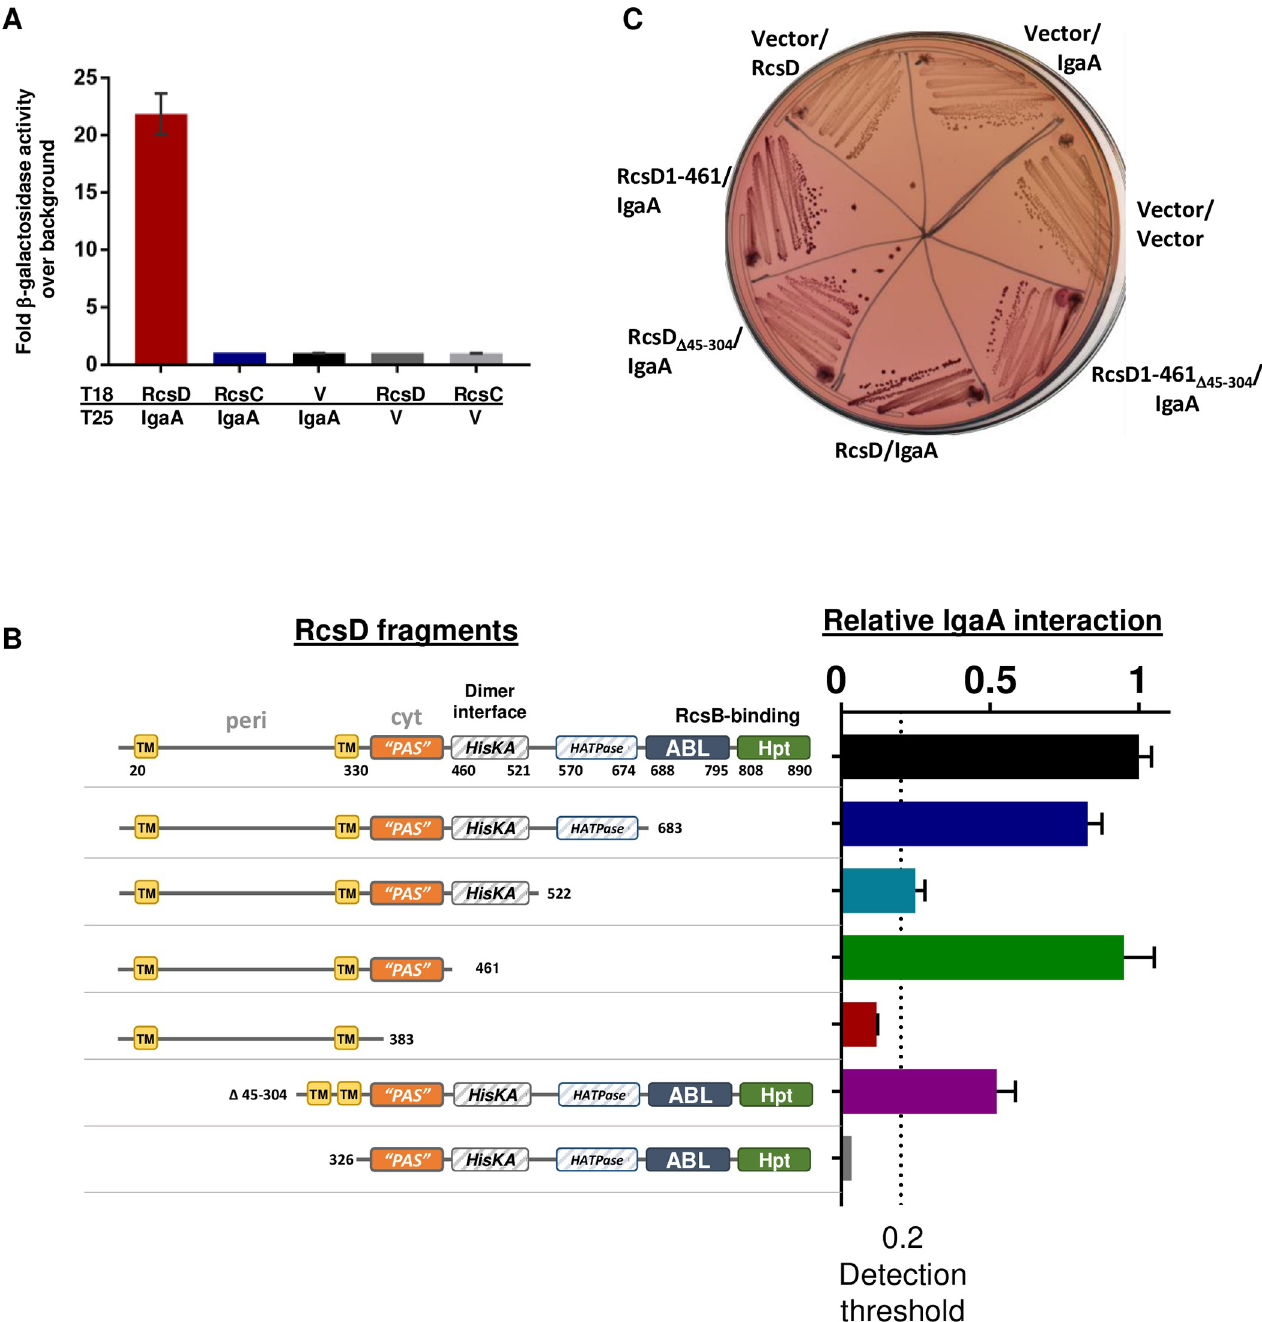
Fig 2. Interaction of IgaA with RcsD. A. Beta-galactosidase activity was measured in cyaA deficient cells (strain BTH101) containing a dual plasmid system encoding the T18 and T25 domains of adenylate cyclase fused to proteins of interest and the expression measured compared to background. Each protein fusion plasmid paired with its cognate vector (V) produces very little activity; the three controls were averaged and used as “background” for normalization. Error bars (some too small to be visible) represent standard deviation of three assays. Fusions present are IgaA-T25, RcsD-T18, and RcsC-T18. Beta- galactosidase activities, measured in Miller units, results obtained with the fusions in the opposite orientation (IgaA-T18, RcsD-T25, RcsC-T25), and in strains mutant for rcs genes to test roles of other Rcs proteins on the interaction, are shown in S2A–S2D Fig. B. Relative ratio of RcsD fragment binding to IgaA was determined by comparing the interaction of RcsD truncations to the interaction between full length RcsD and IgaA, normalized to 1 (top black bar). Extent of RcsD present is shown schematically next to the bar graph. The dotted line at y = 0.2 represents the threshold set here for reliable interaction detection, 4x over background signal. This data is compiled from separate sets of assays, each normalized relative to the IgaA/RcsD signal in that experiment. In most cases the IgaA/RcsD interaction is 20x over background, usually 1000 Miller units compared to 50 Miller units for the background control. All measurements were